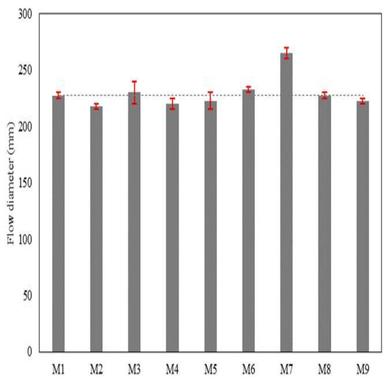
Flow diameters of mortar mixtures with different substitute materials (Results were taken as the average of two measurements, the error bar represents the standard deviation).